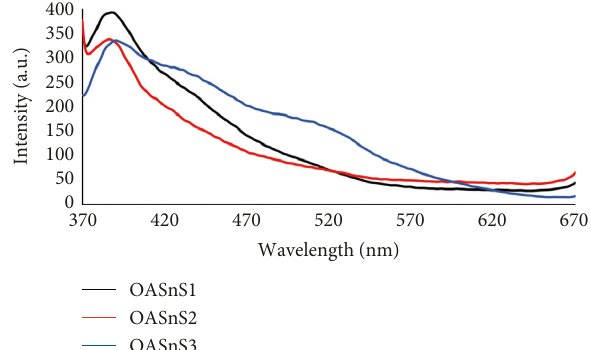
Figure 6: Photoluminescence spectra of OASnS.